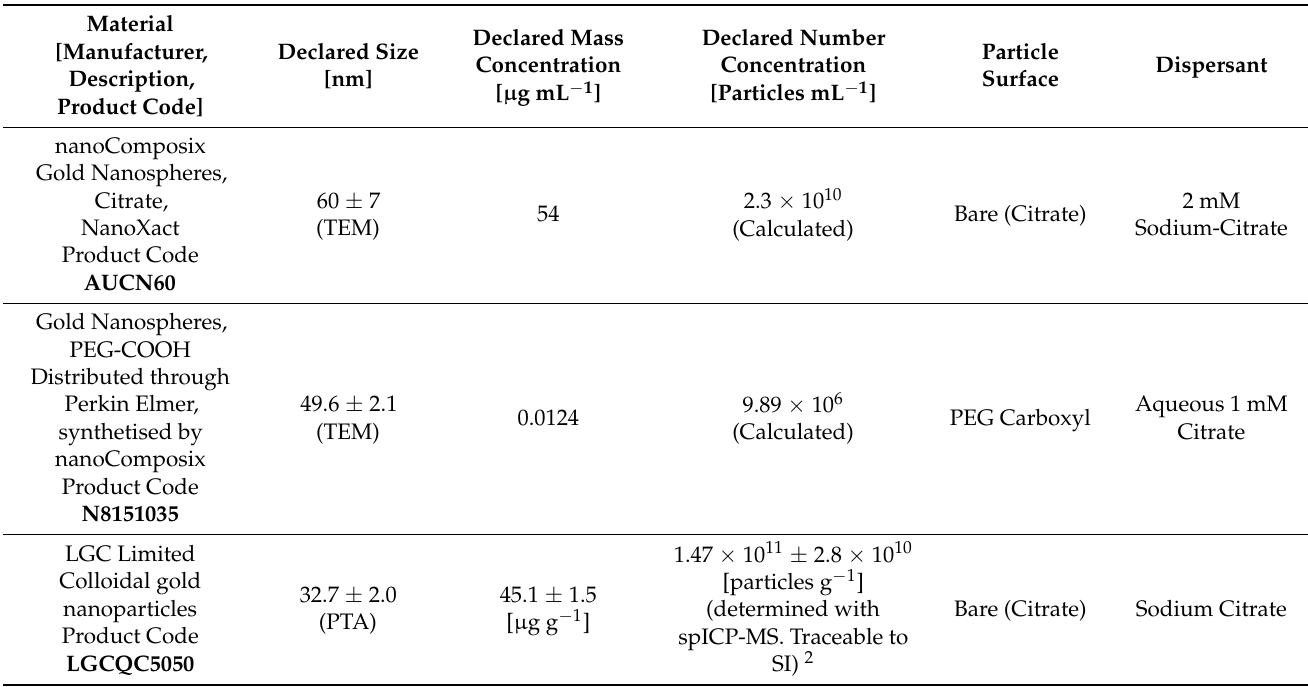
Table 2. Gold nanoparticle suspensions used in this study. In the first column, in bold, product identi- fication names used in all tables and figures (TEM = transmission electron microscopy; PTA = particle tracking